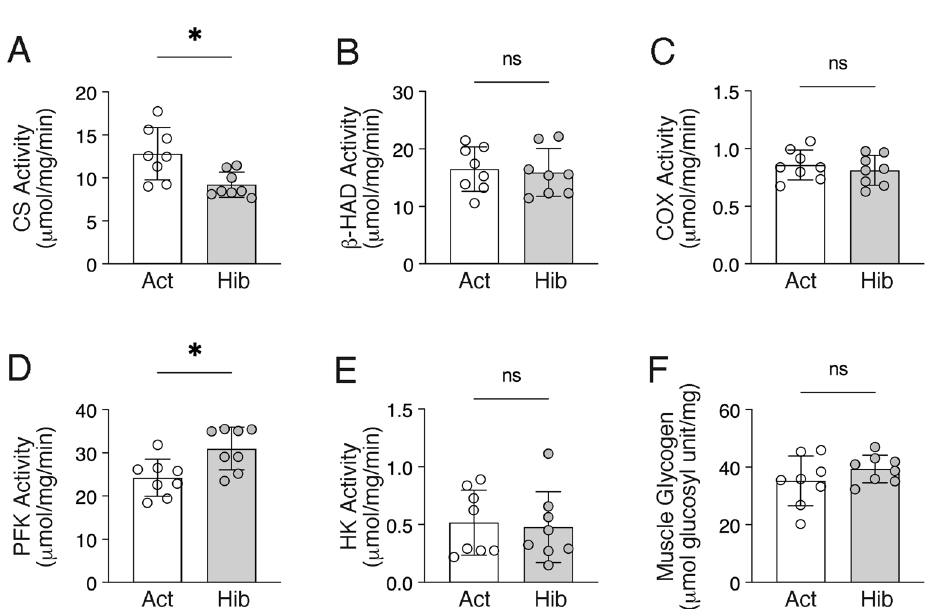
Figure 7. Enzyme activities of oxidative and glycolytic metabolism in bear skeletal muscles during hibernation. Mitochondrial enzyme activities of citrate synthase ( A ), β-HAD ( B ), and cytochrome c oxidase ( C ), along with enzyme activities of glycolysis, including phosphofructokinase ( D ) and hexokinase ( E ) were quantified. ( F ) Muscle glycogen content was determined (mmol glucosyl unit/mg). n = 8 in each group. Data are expressed as mean ± standard deviation (SD). Significant differences: *p < 0.05between active versus hibernation